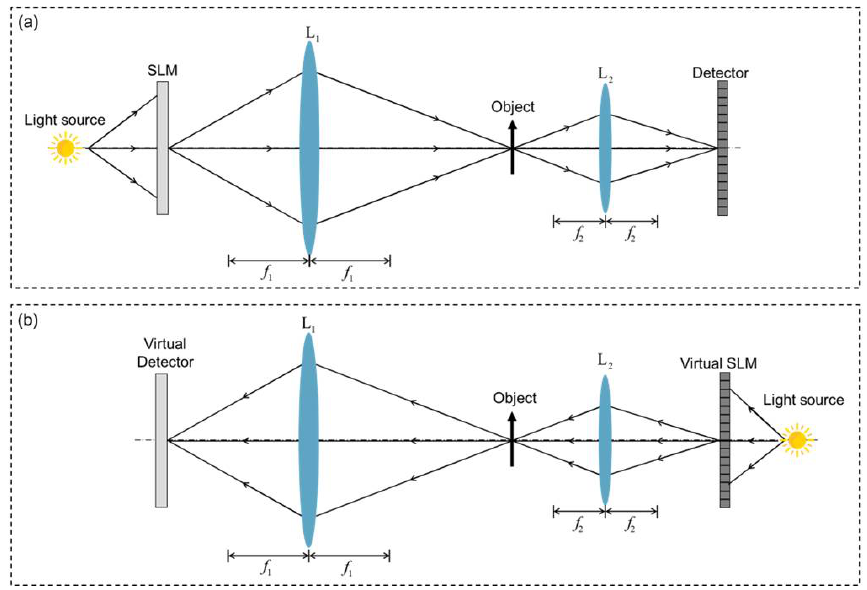
Figure 1. The imaging configuration of dual photography in the mode of structured illumination: ( a ) the primal configuration; ( b ) the dual configuration.